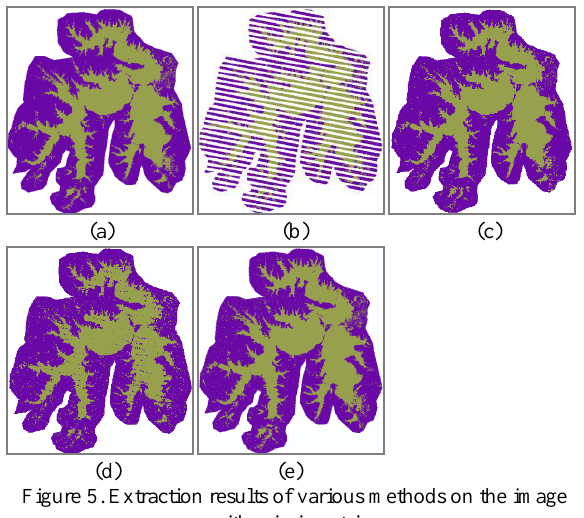
Figure 5. Extraction results of various methods on the image with missing strips (a) True image (b) Image with missing strips (c) Result of PSM